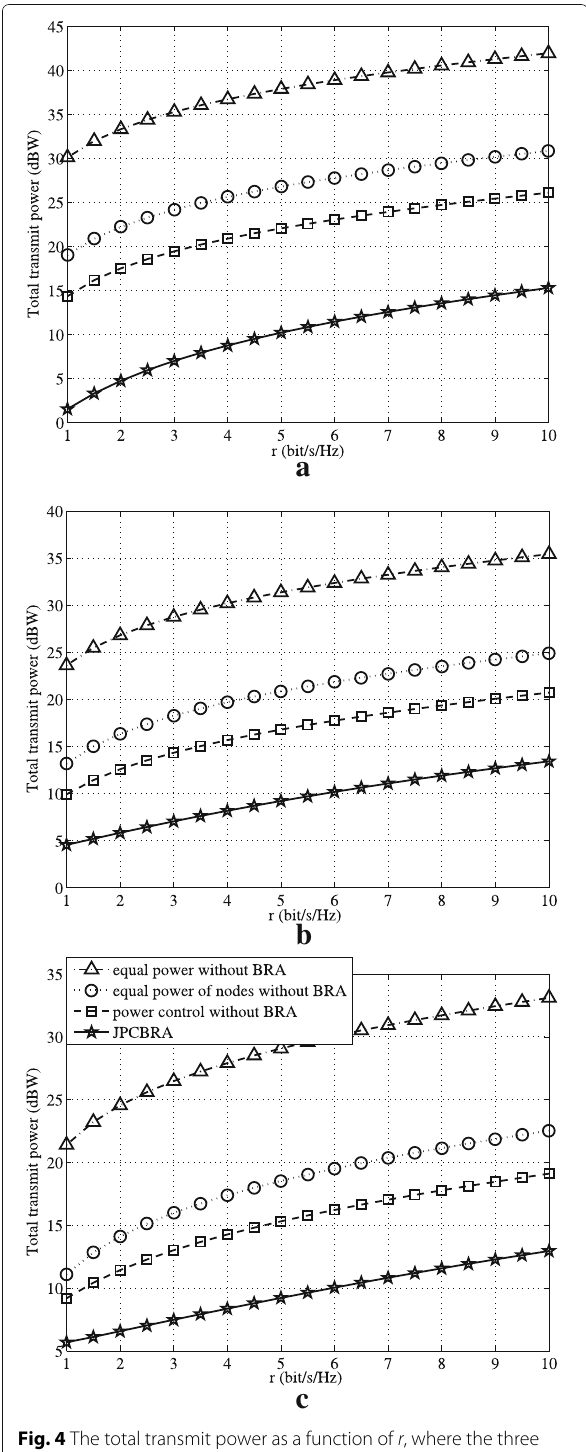
Fig. 4 The total transmit power as a function of r , where the three channel cases considered in Fig. 2 are involved, the parameter K is maintained the same as before and r is ranged from 1 to 10